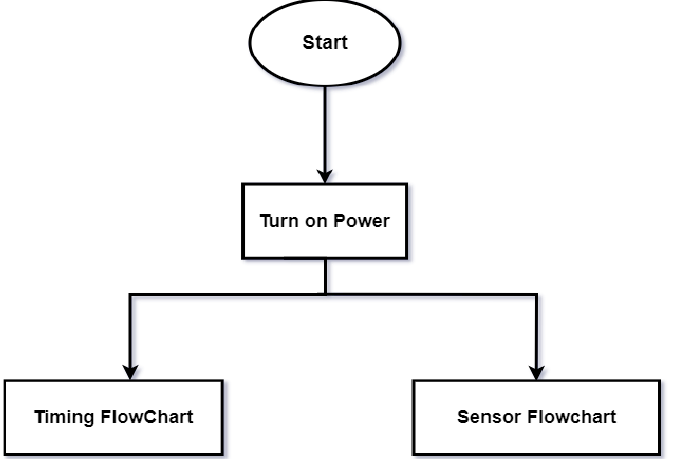
Figure 3. DigiIncubator system flowchart